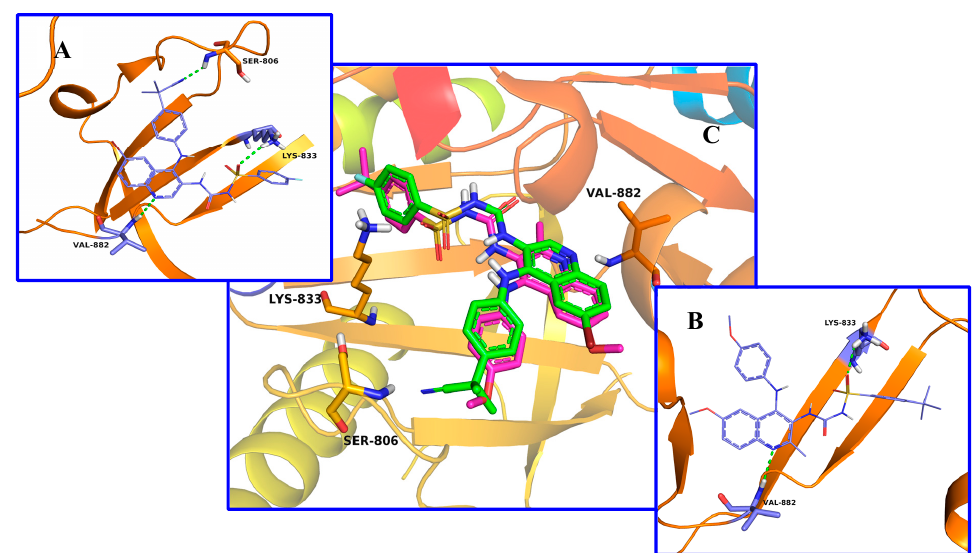
Figure 3. ( A ) The binding mode of compound 19a with PI3K γ (3L08) kinase; ( B ) the binding mode of compound 23b with PI3K γ kinase; and ( C ) the contrast of binding mode between compound 19a (green) and 23b (red).